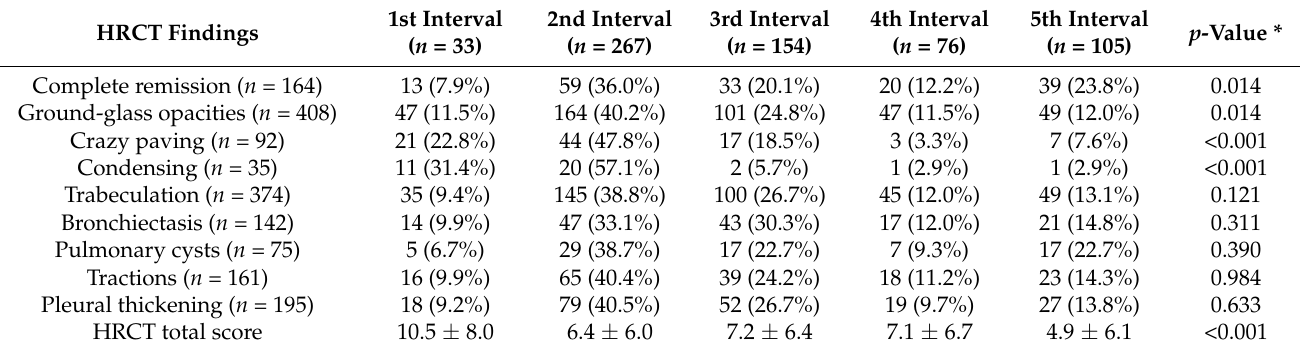
from the first positive COVID-19